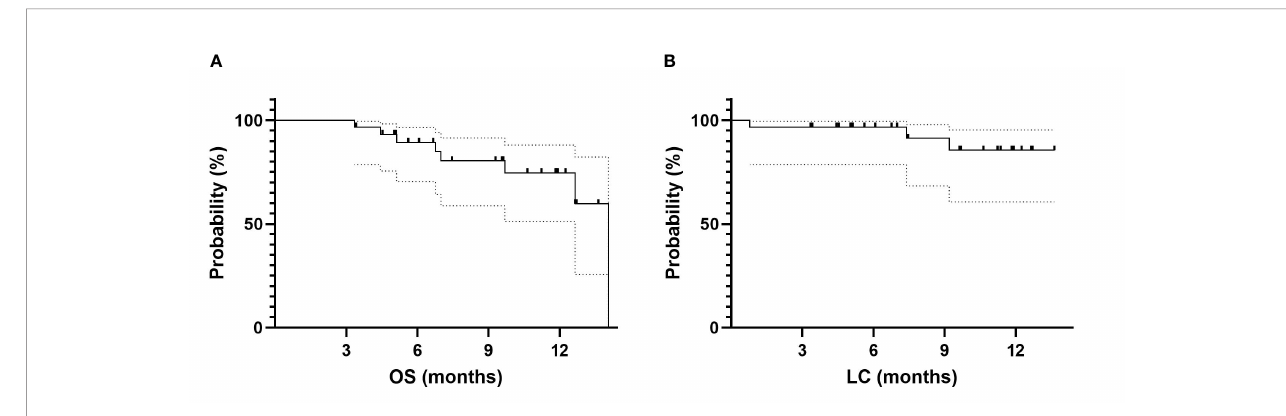
FIGURE 3 | Survival date for the whole cohort. (A) OS for the whole cohort. (B) LC for the whole cohort. OS, overall survival; LC, local